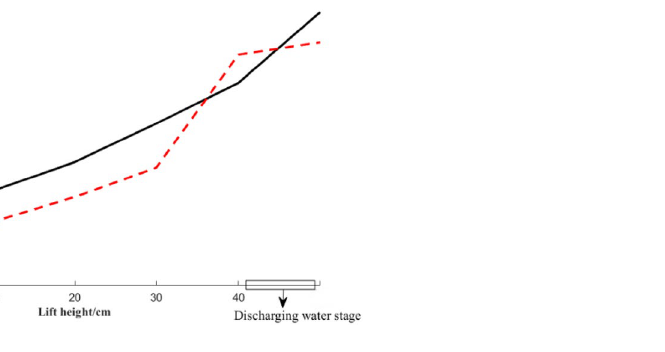
Figure 14. Ballast time change comparison